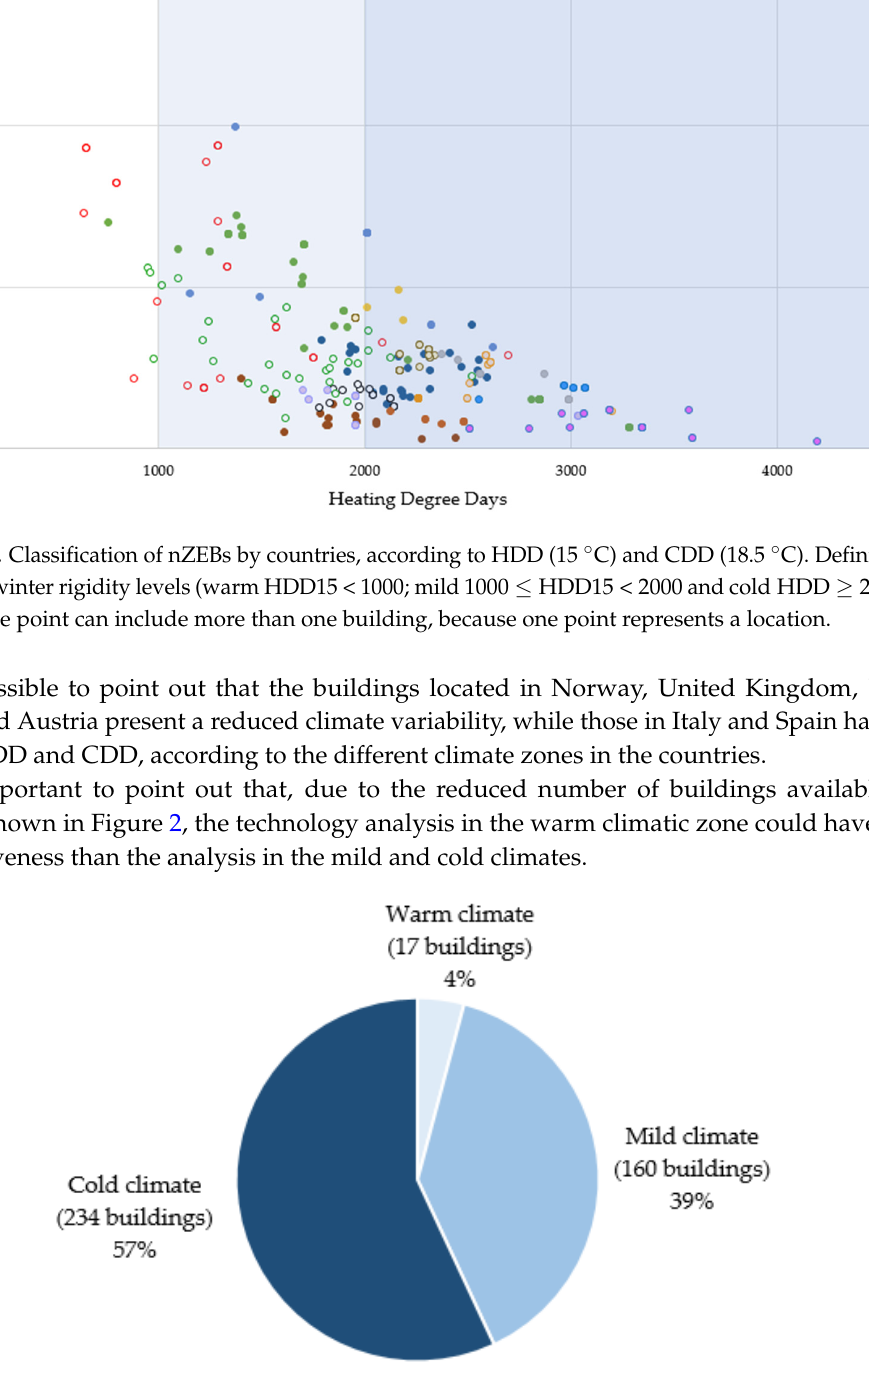
Figure 2. Share of nZEBs collected in relation to the climatic zones.